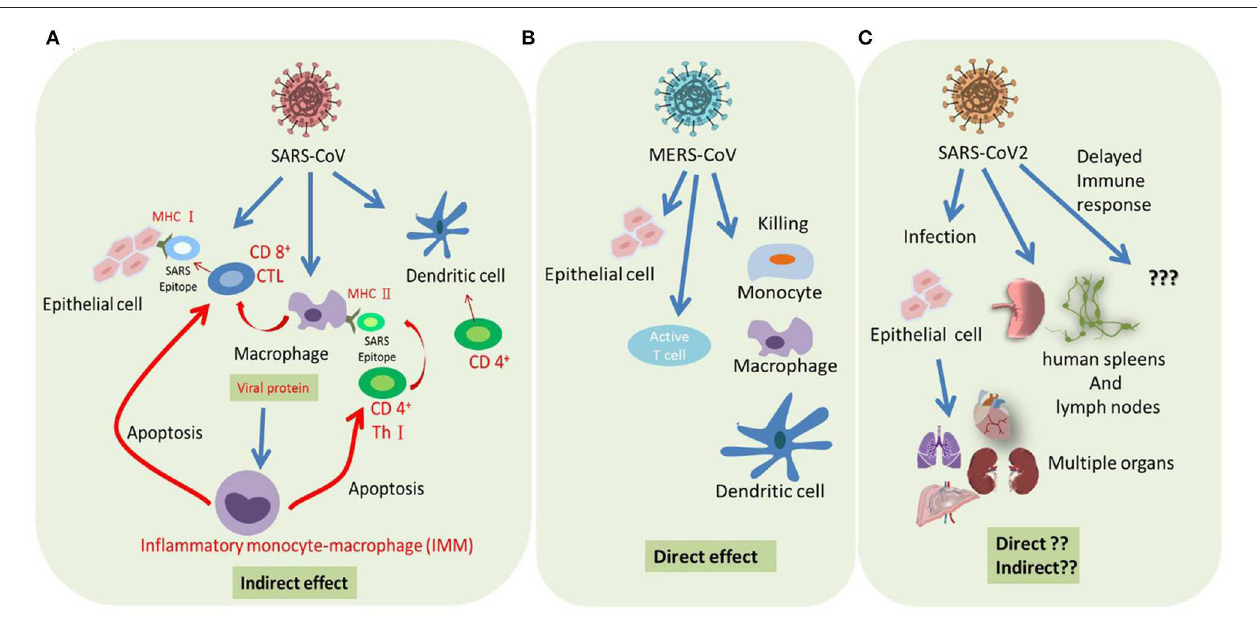
FIGURE 2 | Summary of host immune response modulated by severe coronaviruses. (A) SARS-CoV infected epithelial cells represents SARS epitope by MHC I to recruit CD8 + cytotoxic T cells (CTL). Macrophage and dendritic cells (DCs) are infected by SARS-CoV and represent SARS epitope by MHC II to recruit CD4 + helper